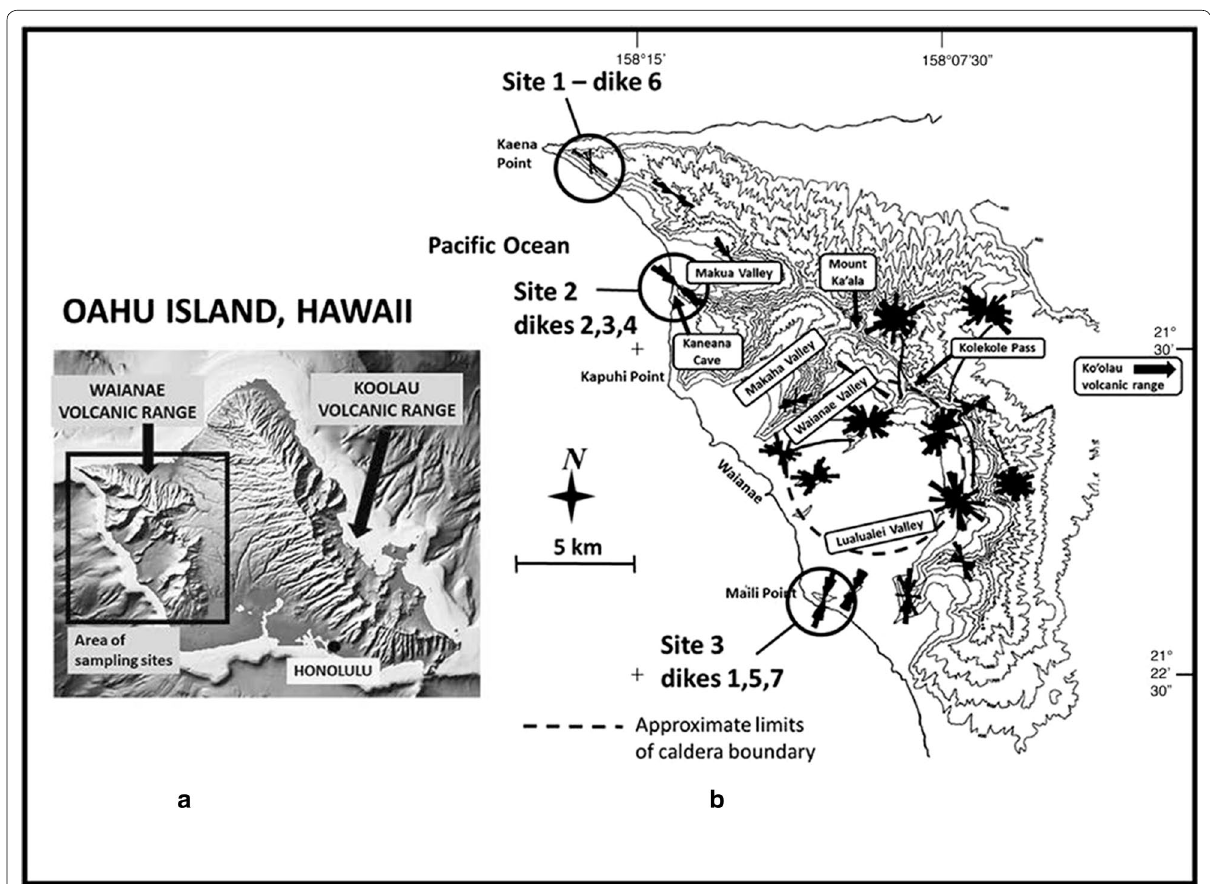
Fig. 1 a Simplified view of Oahu with Digital Elevation Model (NOAA—Digital Elevation Models: https ://www.ngdc.noaa.gov/mgg/coast al/coast al.html) and the two main volcanic structures, the Koolau and Wai’anae volcanic ranges. The sampling sites area over the Wai’anae volcano is indicated, b elevation contour map of the Wai’anae volcano, dike orientations (adapted from Zbinden and Sinton 1988) and site locations of this